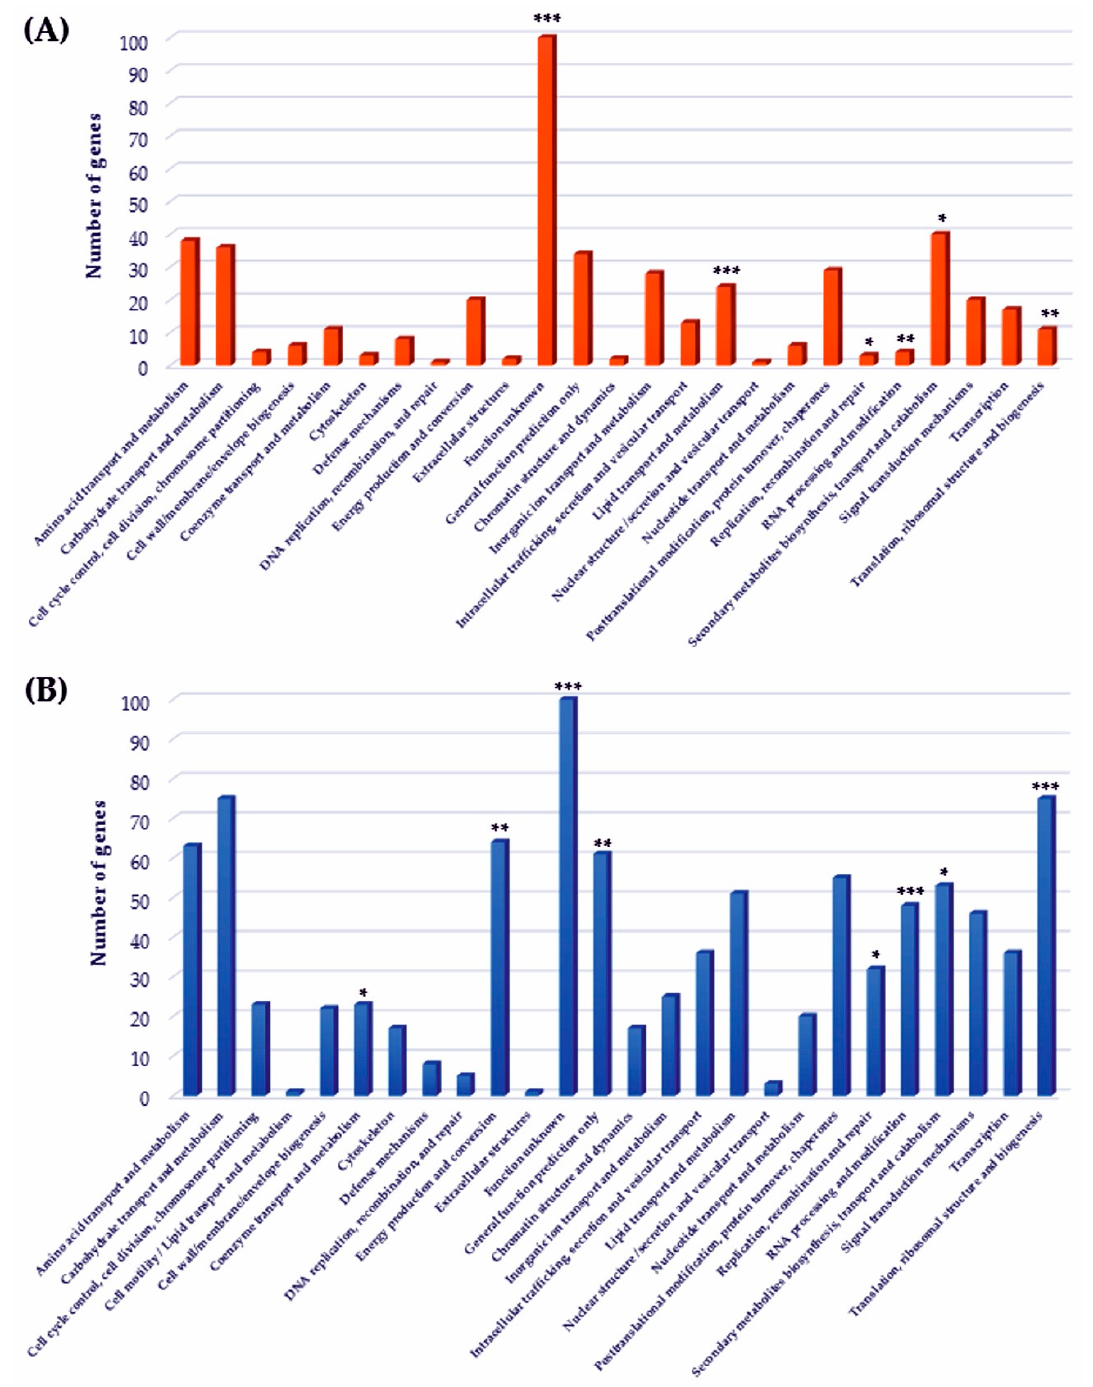
Figure 3. The most significant pathways affected by vapors of eight different EOs. Based on the results of the GO enrichment analysis, data shows changed expression level of genes ( A ) underexpressed and ( B ) overexpressed. * p ‐ value ≤ 0.05, ** p ‐ value ≤ 0.01 and *** p ‐ value ≤ 0.001.